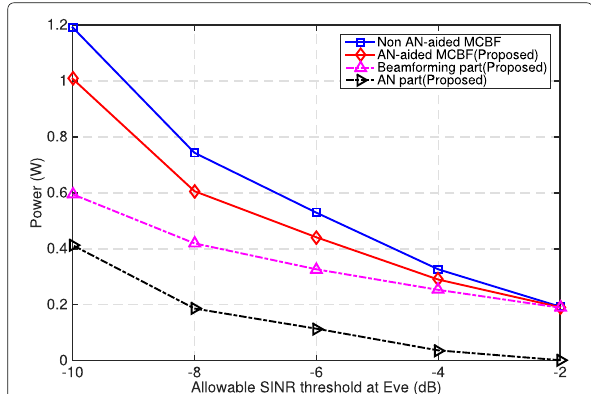
Fig. 5 Required power versus allowable SINR threshold at each